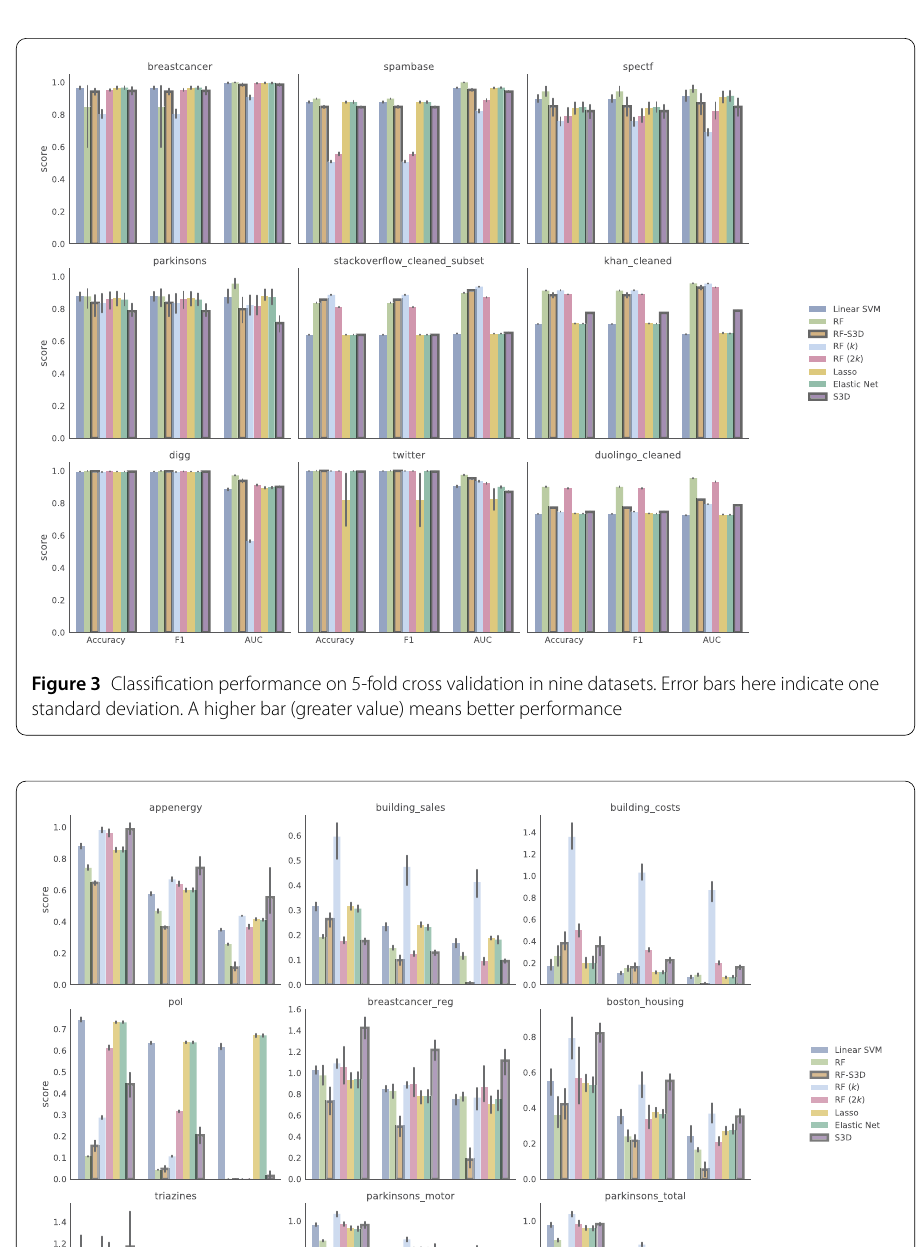
As shown in Sect. 4.2, S3D performs similarly to logistic regression in both classification and regression (Figs. 3 and 4), but uses fewer features (Fig. 5). Finally, both random forests [25] and linear SVM [26] are proven to be adequately powerful in prediction tasks while being relatively simple to